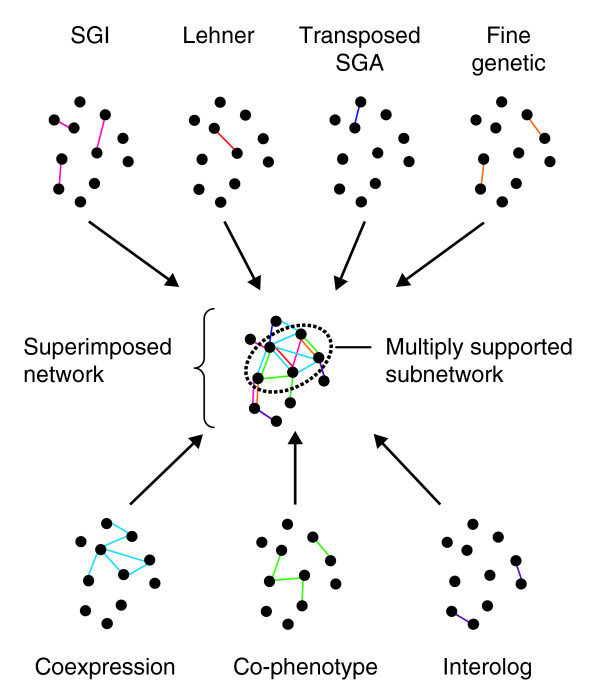
A schematic diagram of the construction of a superimposed network. Networks collected or constructed from various data sources were combined to create the superimposed network. Nodes represent genes; edges are colored according to the data type they represent.